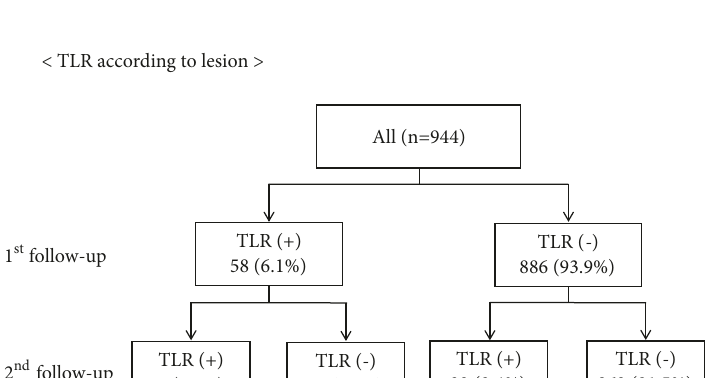
Figure 2: Incidence of target lesion revascularization.